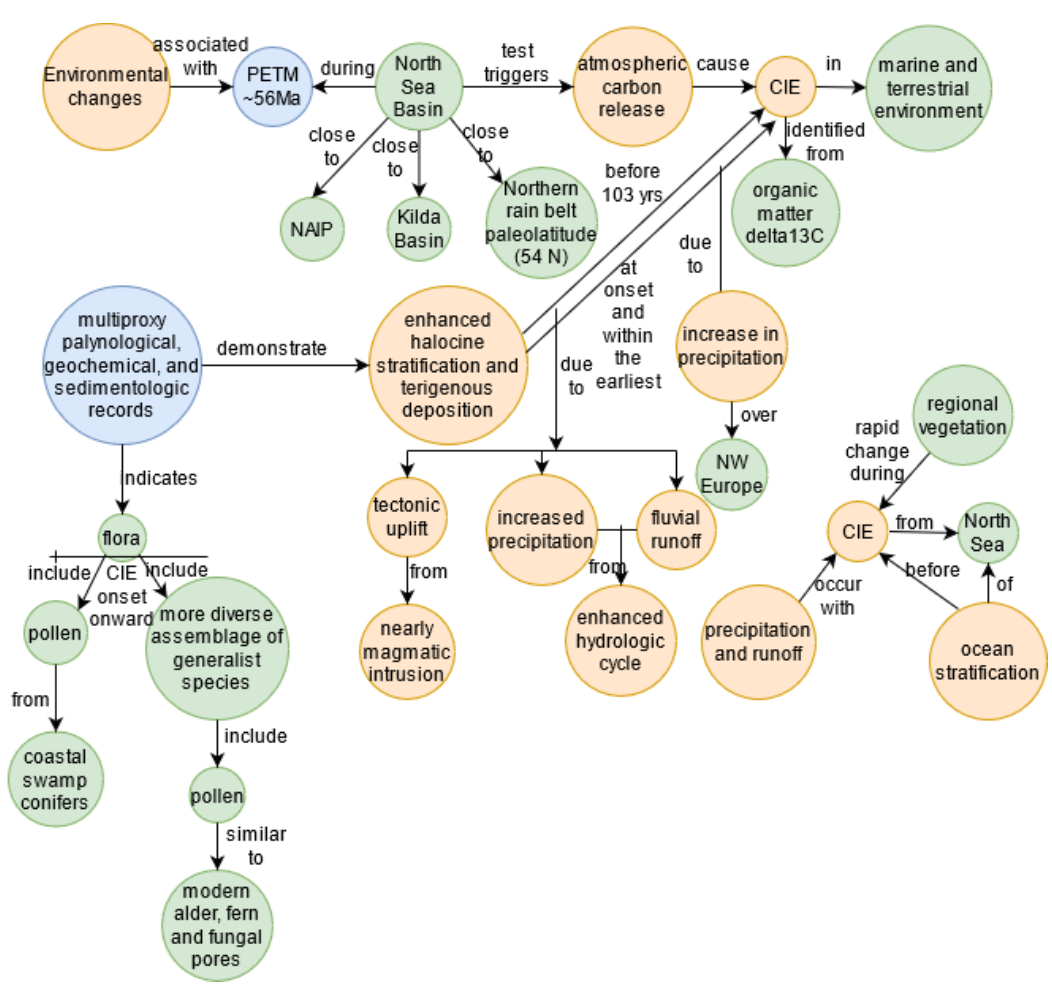
Figure A3. Structured KG representation of a Earth Science domain publication Abstract [67] as process, method, material, and data typed entities.